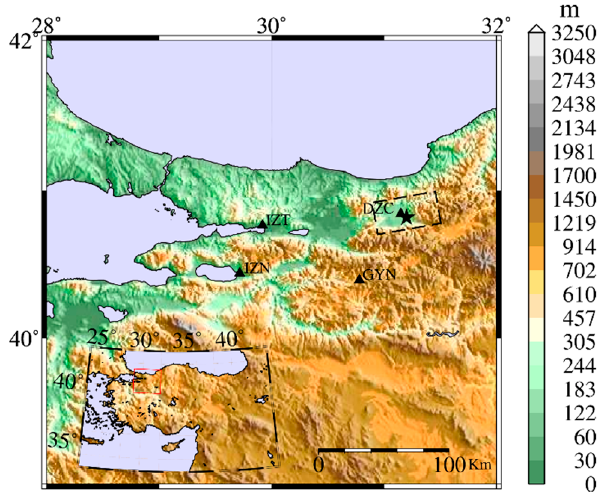
Figure 2. Selected stations along with the epicenter of the 1999 Duzce event where the rectangular box shows the fault projection. Table 2. Information on the selected stations corresponding to the 1999 Duzce (Turkey) event (Mw = 7.1).